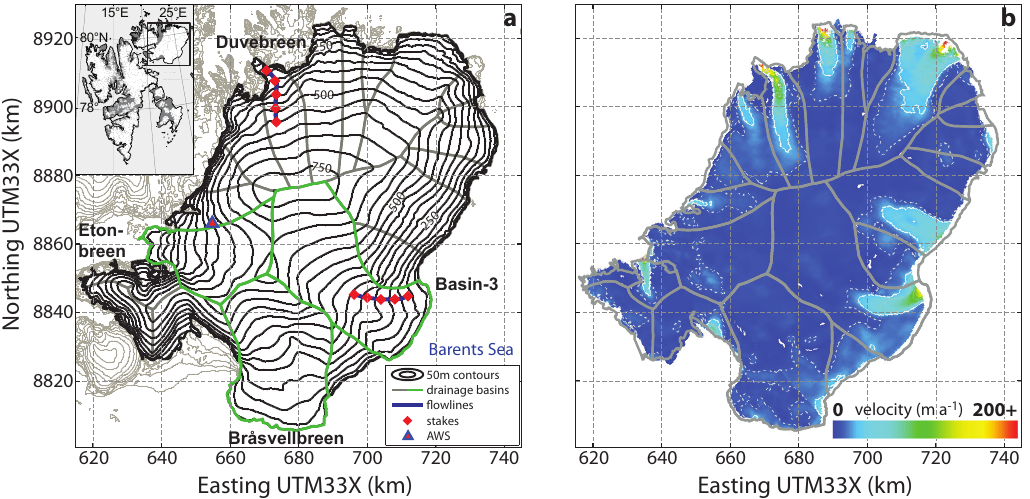
Fig. 1. Topographic and dynamic characteristics of Austfonna. (a) Surface topography of Austfonna with 50m elevation contours according to a new DEM by Moholdt and K¨a¨ab (2012). The black rectangle in the inset indicates the location within the Svalbard archipelago. Drainage basins are outlined in solid grey, in the case of the known surge-type basins in solid green. The survey routes along the central flowlines of Duvebreen and Basin-3 are marked in solid blue, the position of stakes with red dots and the AWS on Etonbreen with a triangle. (b) Surface velocity structure of Austfonna derived from ERS-1/2 SAR scenes acquired between December 1995 and January 1996. Dashed contours indicate a velocity of 10ma − 1 , solid contours are at 25ma − 1 intervals. Modified from Dowdeswell et al., Iceberg calving flux and mass balance of the Austfonna ice cap on Nordaustlandet, Svalbard, J. Geophys. Res., 113, F03022, 2008. ©2008 American Geophysical Union, by permission of the American Geophysical